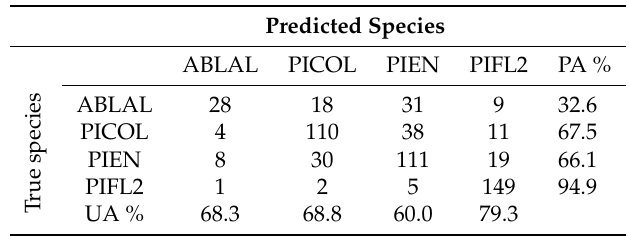
Table 4. Confusion matrix with User’s Accuracy (UA) and Producer’s Accuracy (PA) per species for the training set that yielded the highest overall